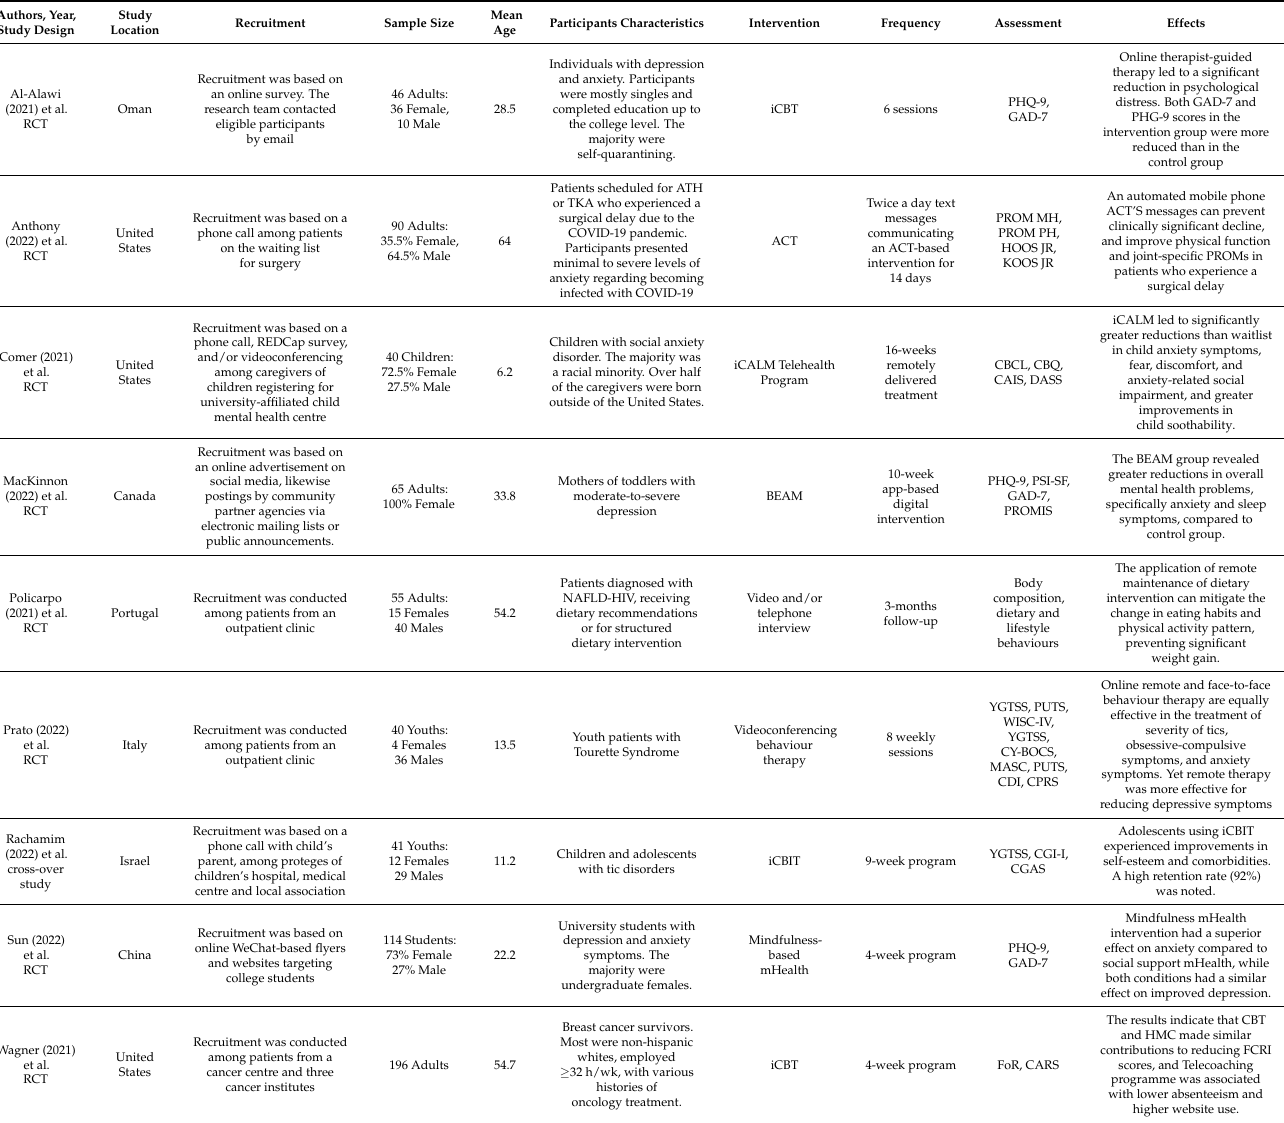
Table 1. Characteristics of the included